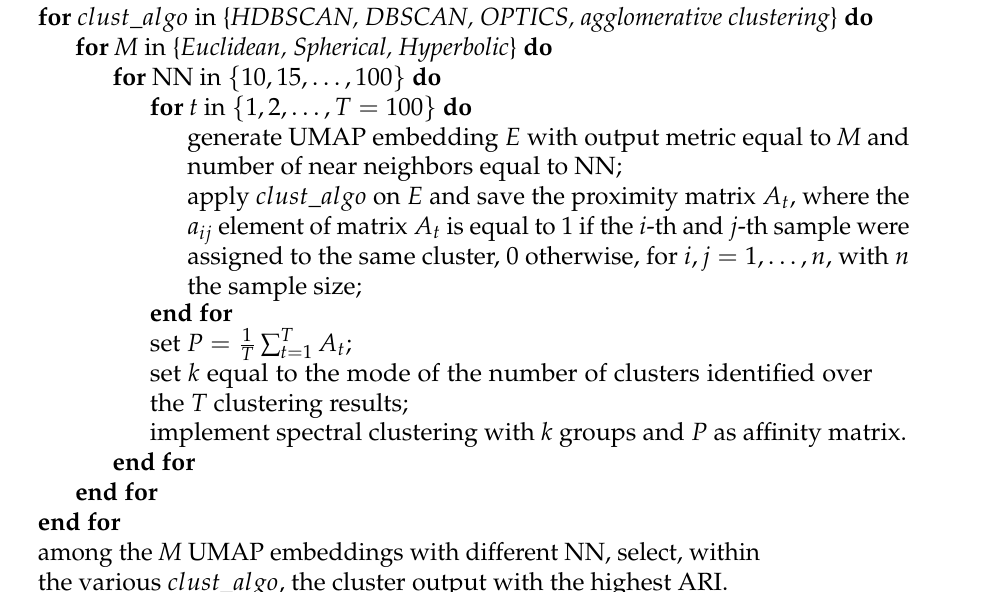
Algorithm 1 Pseudocode of the